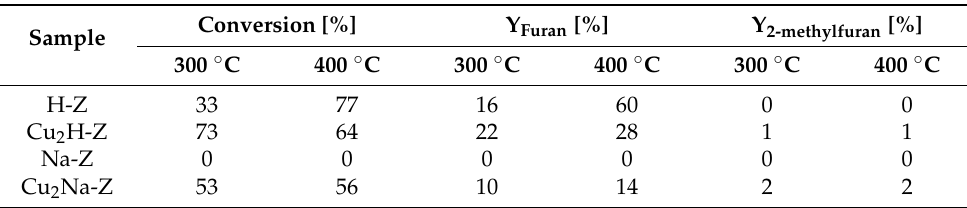
Table 2. Catalytic properties in dependence on reaction temperature and the presence of active center types in the studied